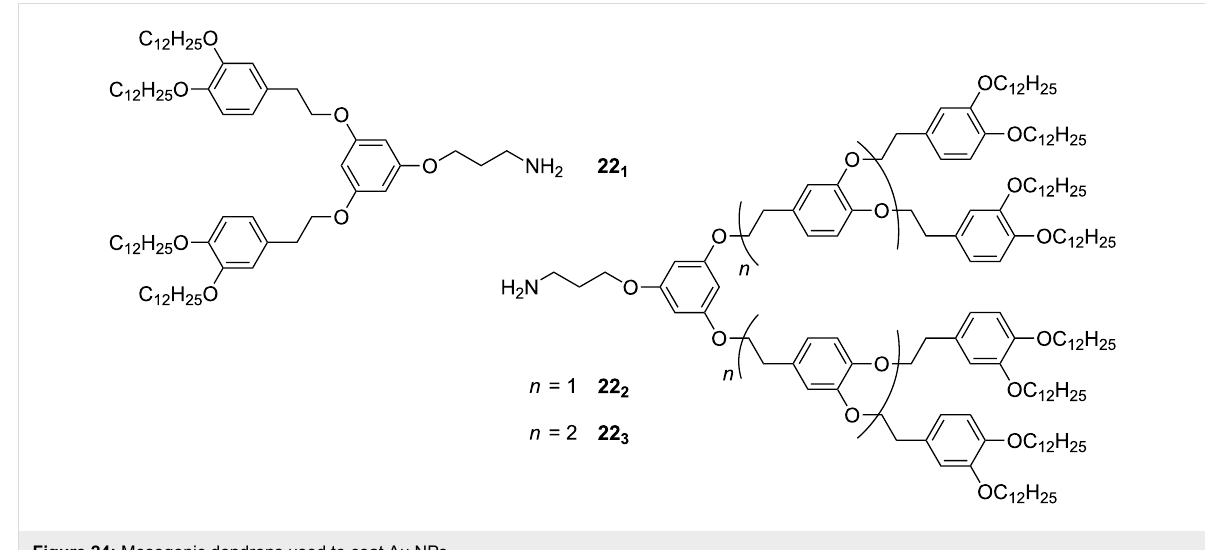
Figure 24: Mesogenic dendrons used to coat Au NPs.